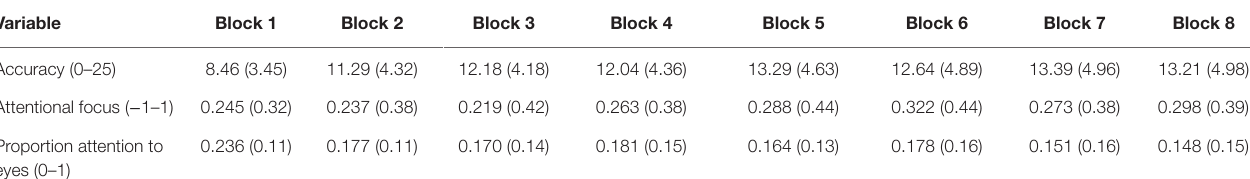
TABLE 3 | Means (SD) of the dependent variables per time block in the learning phase.